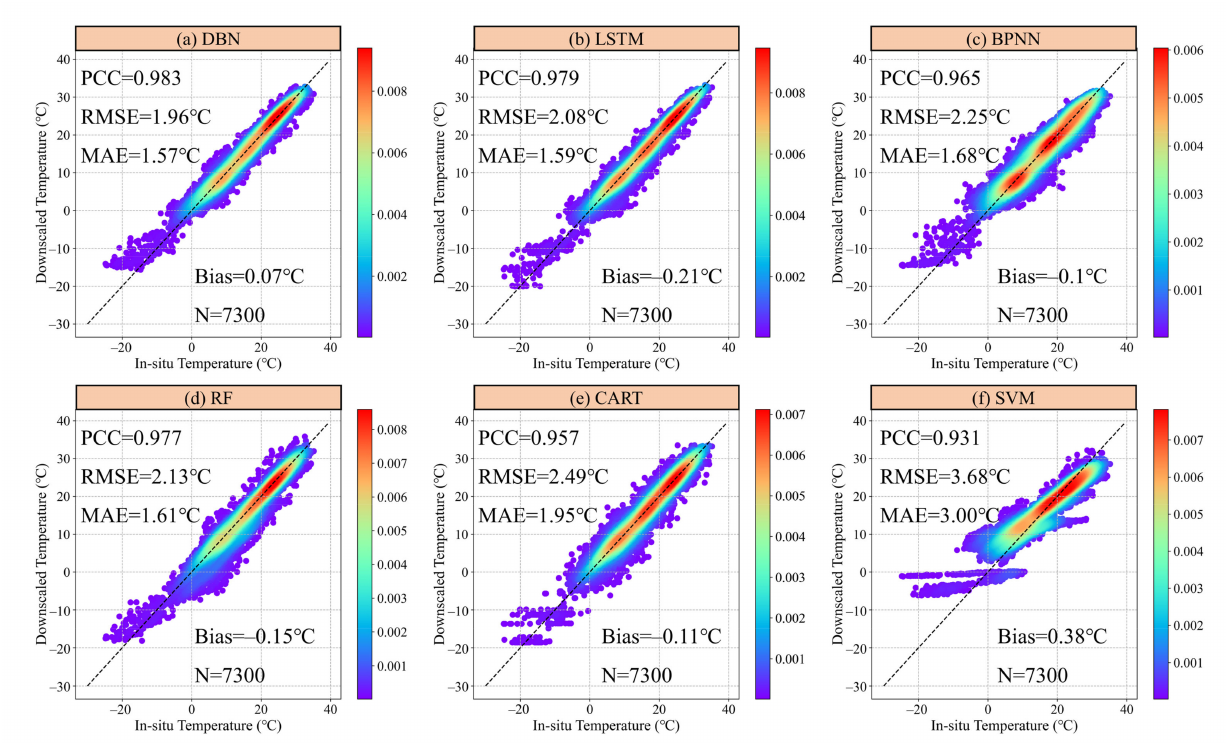
Figure 14. The comparative analysis of six downscaling algorithms in generating 3H temperature. ( a – f ) represent the performance of DBN, LSTM, BPNN, RF, CART, and SVM on 20 validation station,